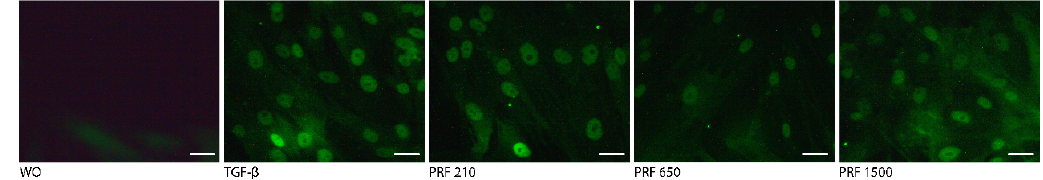
Figure 4. PRF lysates prepared at 210 g , 650 g and 1500 g provoked nuclear translocation of Smad2/3. Gingival fibroblasts were exposed for 1 h to 30% of the PRF lysates prepared at different g -forces. Immunofluorescence revealed the nuclear translocation of Smad2/3 by all variants of PRF lysates compared to the untreated control. Scale bars are 100 µm. The Figure is representative for three independent experiments.